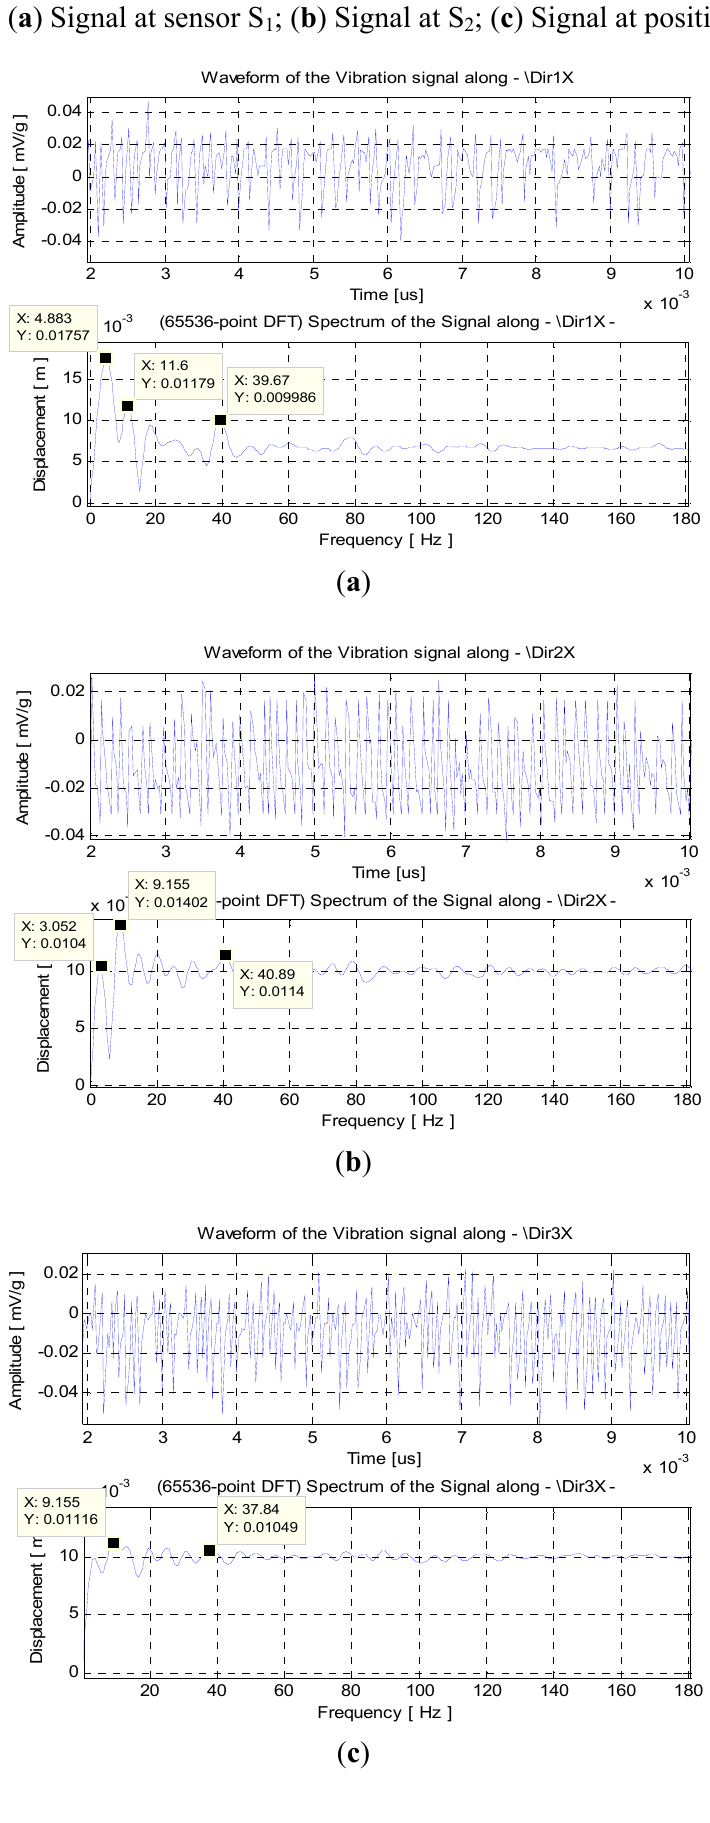
Figure 14. ( a ) Signal at sensor S